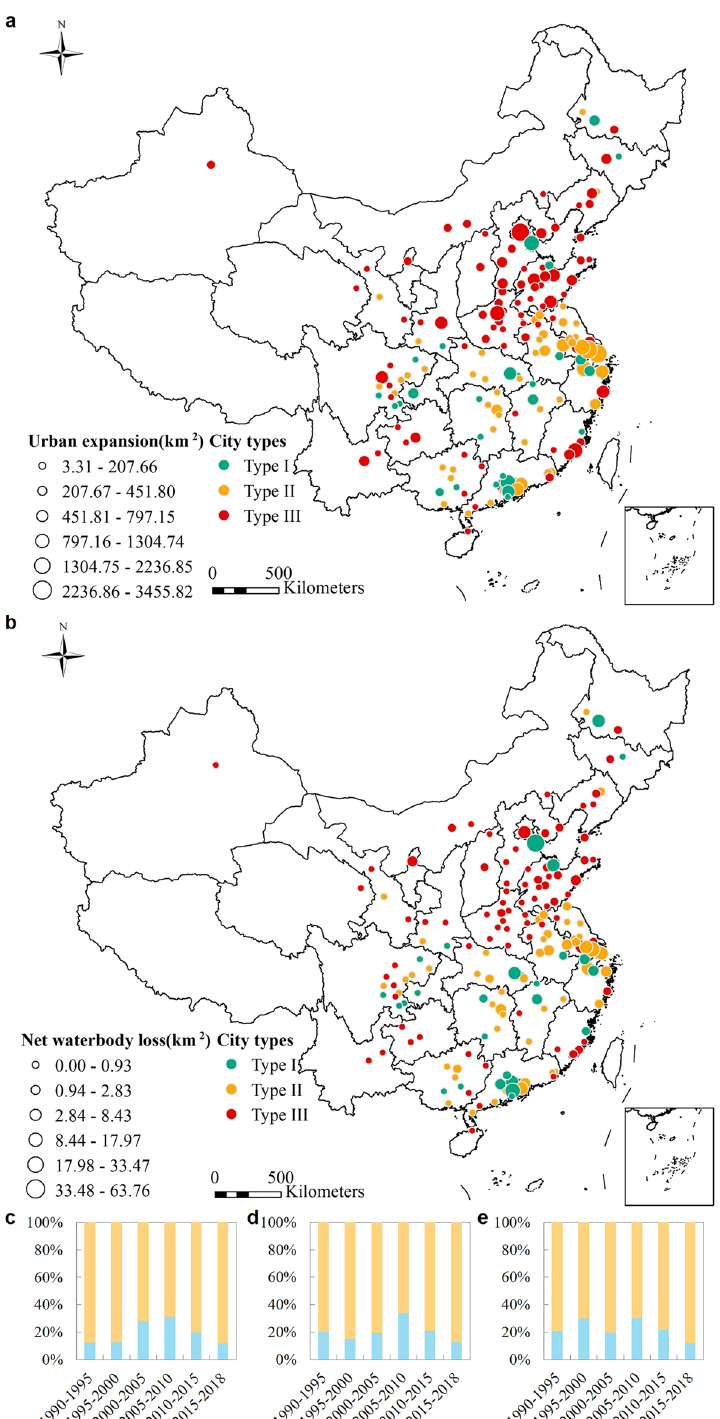
Figure 1. Waterbody loss in urban expansion: ( a ) Spatial distribution of urban expansion in different types of cities. ( b ) Spatial distribution of waterbody loss in different types of cities. ( c )–( e ) Waterbody loss (WL) and waterbody preservation (WP) rate as a function of time in areas of urban expansion in cities of Type I–III, respectively. The map was generated by ESRI ArcGIS 10.2 software available at ESRI website (https:// www. esri. com/ en- us/ arcgis/ produ cts/ arcgis- platf orm/ overv iew). And the administrative boundary shapefile is available at RESDC website (https:// www. resdc.